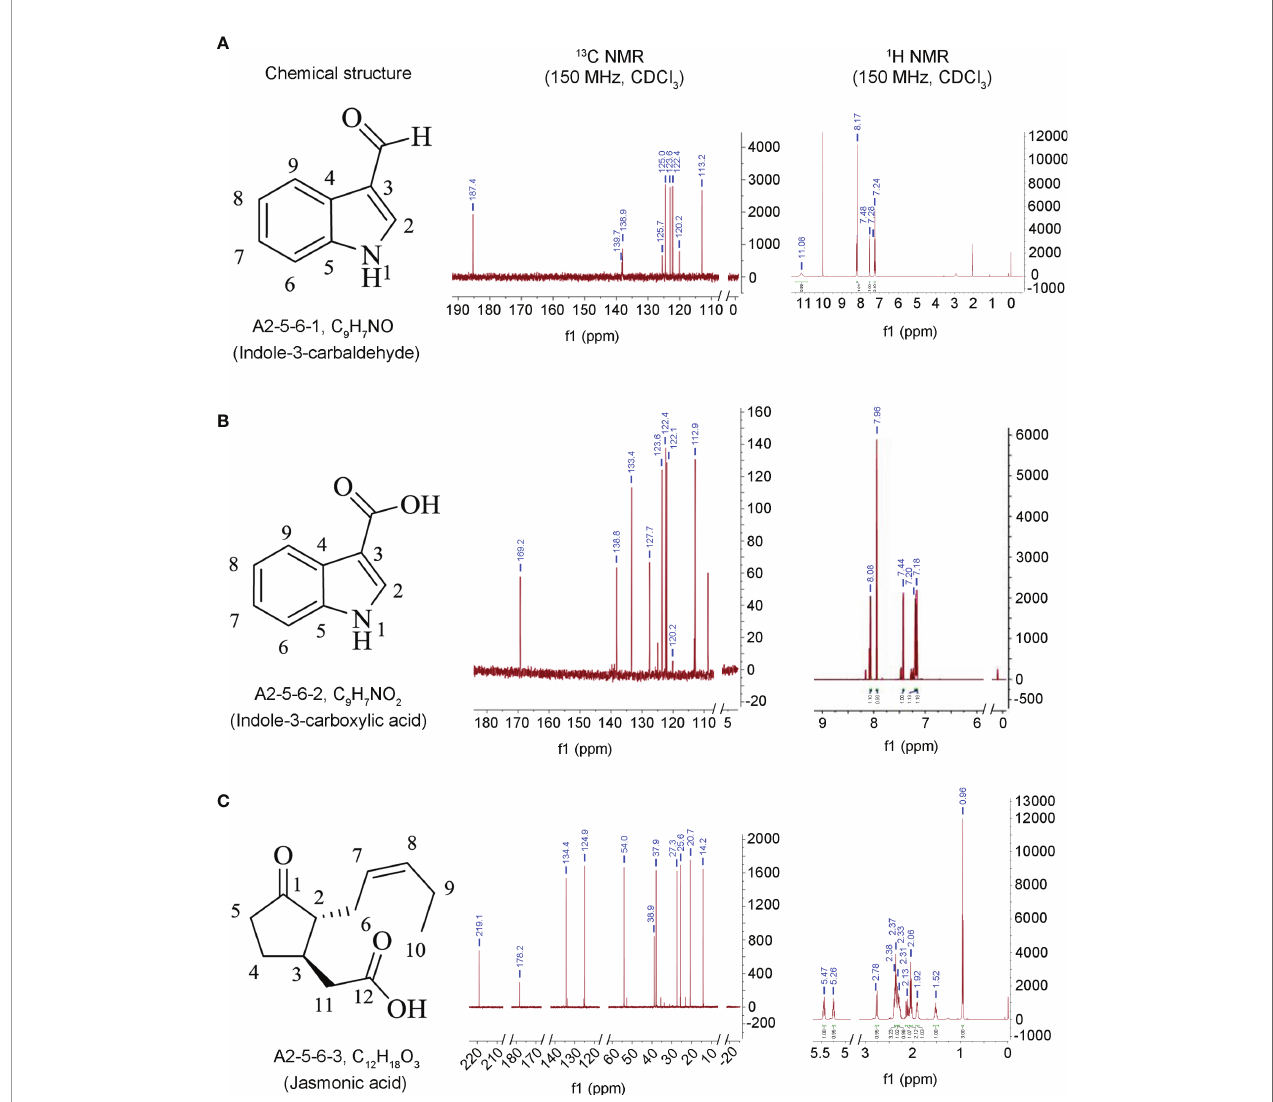
FIGURE 1 | Chemical structure and NMR graphs of these compounds isolated from fermentation cultures of L. pseudotheobromae LPS-1. (A) A2-5-6-1, C 9 H 7 NO, indole-3-carbaldehyde. (B) A2-5-6-2, C 9 H 7 NO 2 , indole-3-carboxylic acid. (C) A2-5-6-3, C 12 H 18 O 3 , jasmonic